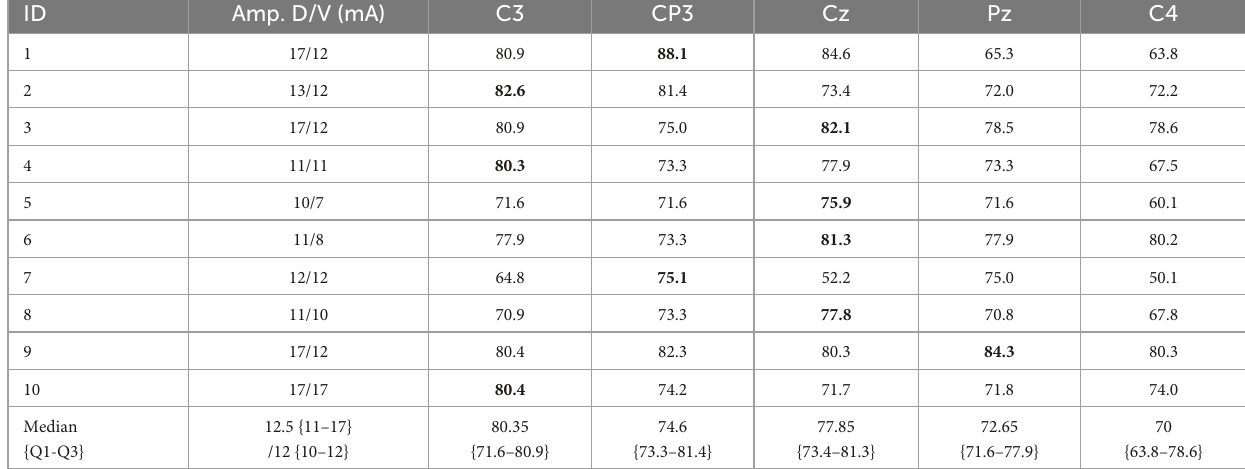
TABLE 2 The BCI performance for all subjects and EEG channels obtained by the optimal feature extraction/selection and classification approach (SVM classifier, SEP10 averaging, and feature